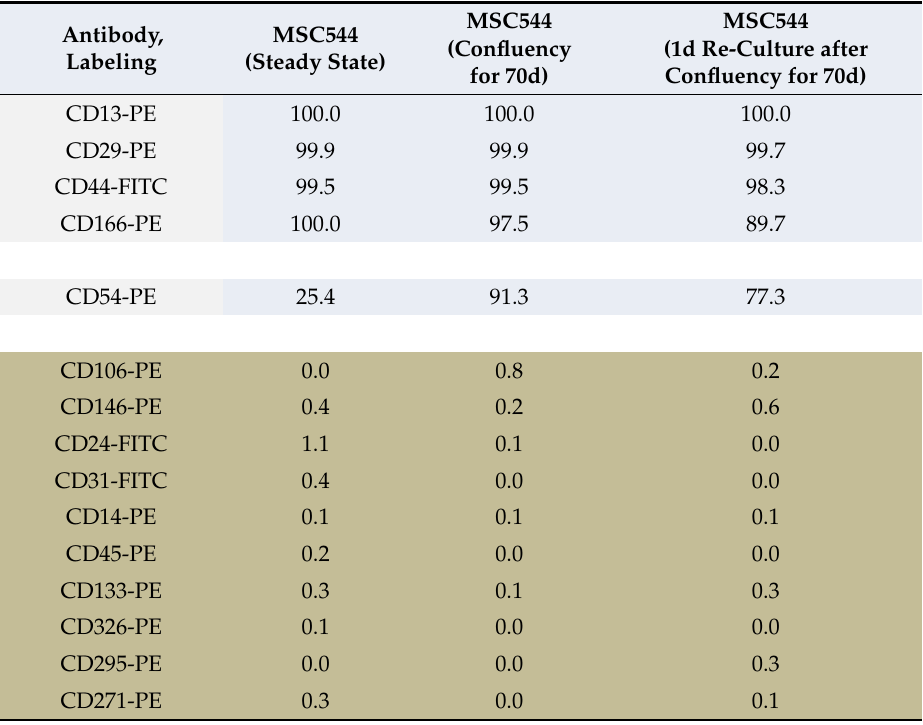
Table 2. Flow cytometry analysis of various detectable expression markers was performed in steady state MSC544 as compared to MSC544 cultured for 70d in confluency and 70d confluent MSC544 after re-culture for 1d in a sub-confluent environment (blue background). Proteins at low to undetectable levels are displayed by a khaki-colored